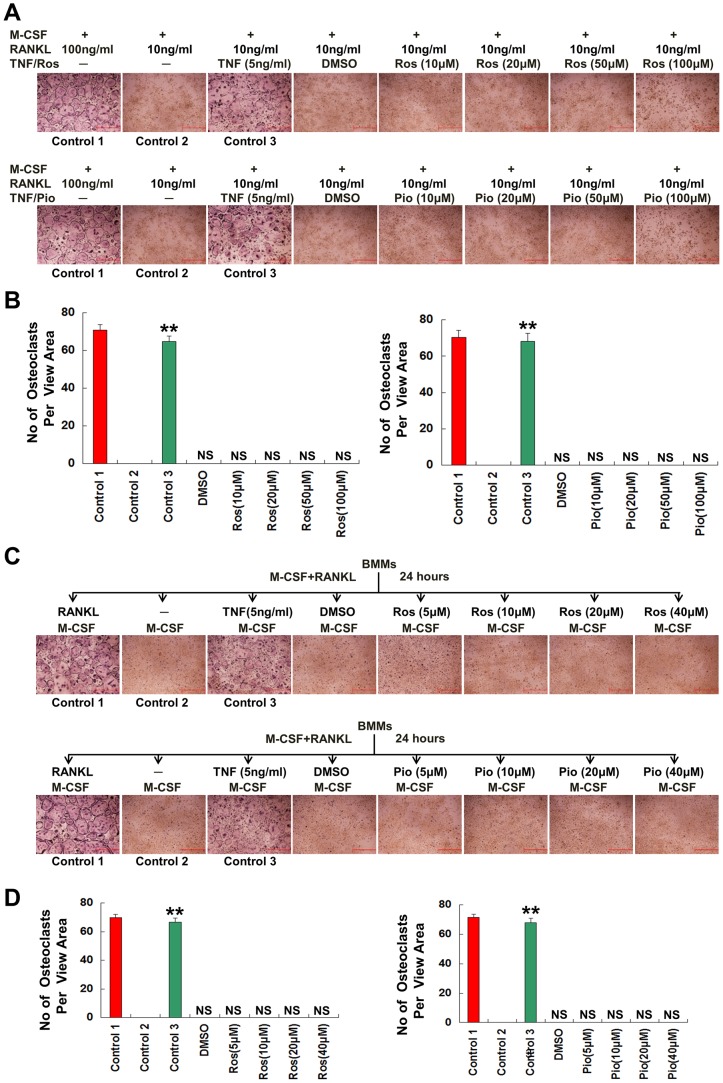
Rosiglitazone and pioglitazone do not induce osteoclastogenesis with low levels of RANKL or RANKL pretreatment.(A) BMMs were treated with M-CSF (44 ng/ml) and RANKL (100 ng/ml) as control 1, M-CSF (44 ng/ml) and RANKL (10 ng/ml) as control 2, M-CSF (44 ng/ml) and RANKL (10 ng/ml) plus TNF-α (TNF, 5 ng/ml) as control 3, M-CSF (44 ng/ml) and RANKL (10 ng/ml) plus DMSO or different doses (5 µM, 10 µM, 20 µM or 40 µM) of rosiglitazone (Ros) or pioglitazone (Pio) for 4 days and then stained for TRAP activity. The assays were performed in triplicate and repeated 3 times. One representative view from each condition is shown. (B) Quantification of the osteoclastogenesis assays in A for Ros (left panel) and Pio (right panel). The number of multinucleated TRAP-positive cells (>3nuclei) per representative view area (40×magnification) was obtained. Bars show averages of three replicates ±S.D. Control 3, DMSO, or TZD-treated cultures were compared with control 2. **: P<0.001. NS: not significant. (C) BMMs were treated with M-CSF (44 ng/ml) and RANKL (100 ng/ml) for 24 hours and then were continued with M-CSF (44 ng/ml) and RANKL (100 ng/ml) as control 1, M-CSF (44 ng/ml) alone as control 2, M-CSF (44 ng/ml) and TNF (5 ng/ml) as control 3, M-CSF (44 ng/ml) and DMSO, or M-CSF (44 ng/ml) plus different doses (5 µM, 10 µM, 20 µM or 40 µM) of Ros or Pio for additional 3 days. The cultures were stained for TRAP activity. The experiments were performed in triplicate and repeated 3 times. One representative view from each condition is shown. (D) Quantification of the osteoclastogenesis assays in A for Ros (left panel) and Pio (right panel). The number of multinucleated TRAP-positive cells (>3nuclei) per representative view area (40×magnification) was obtained. Bars show averages of three replicates ±S.D. Control 3, DMSO, or TZD-treated cultures were compared with control 2. **: P<0.001. NS: not significant.